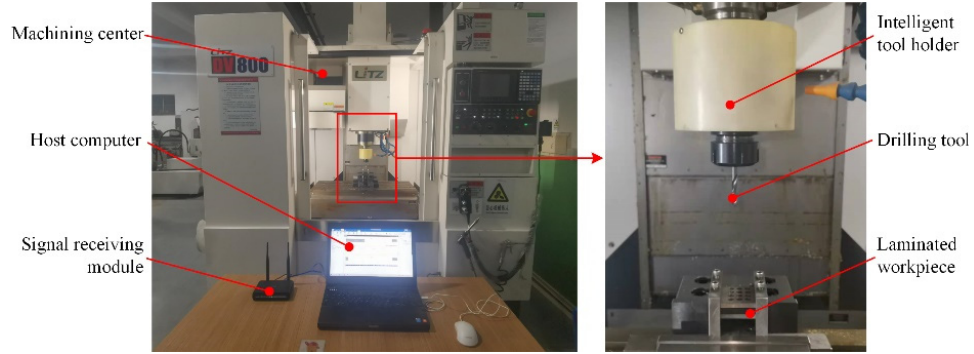
Figure 8. Photographs of the drilling experiment for Ti-CFRP-Ti laminated stacks.